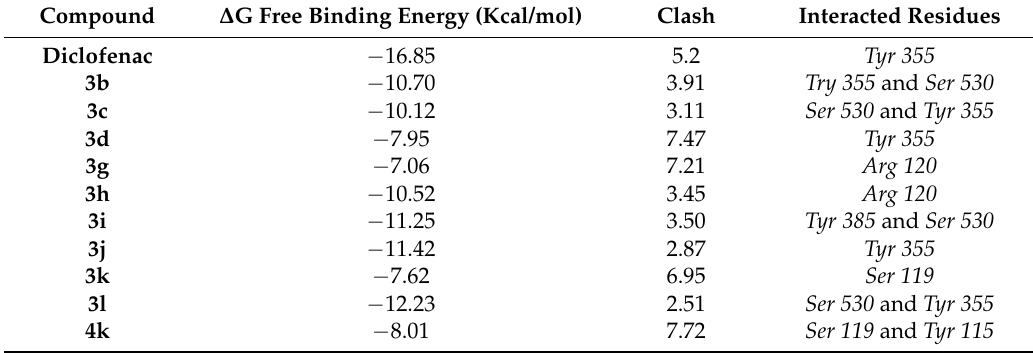
Table 3. Free binding energy and clash score of all tested compounds and Diclofenac (standard COX Inhibitor).